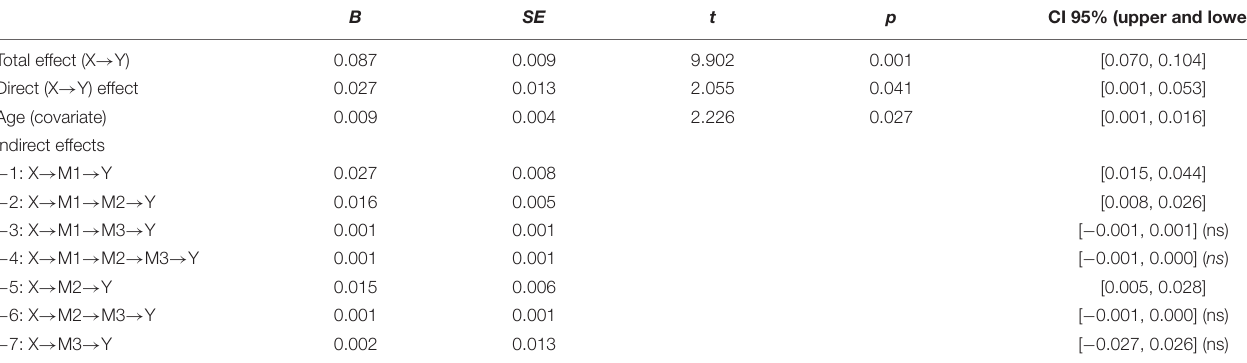
TABLE 3 | Total, direct and indirect effects based on 10,000 bootstrap samples.